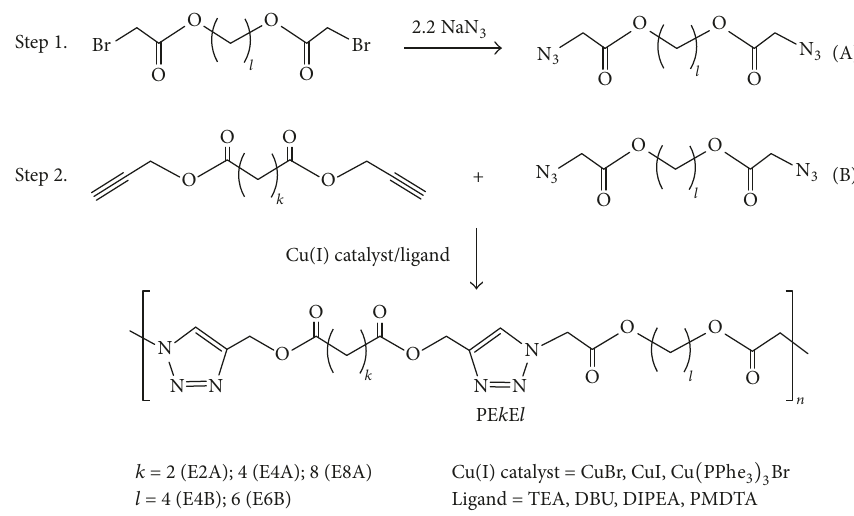
Figure 4: One-pot/two-step/three-component synthesis of click